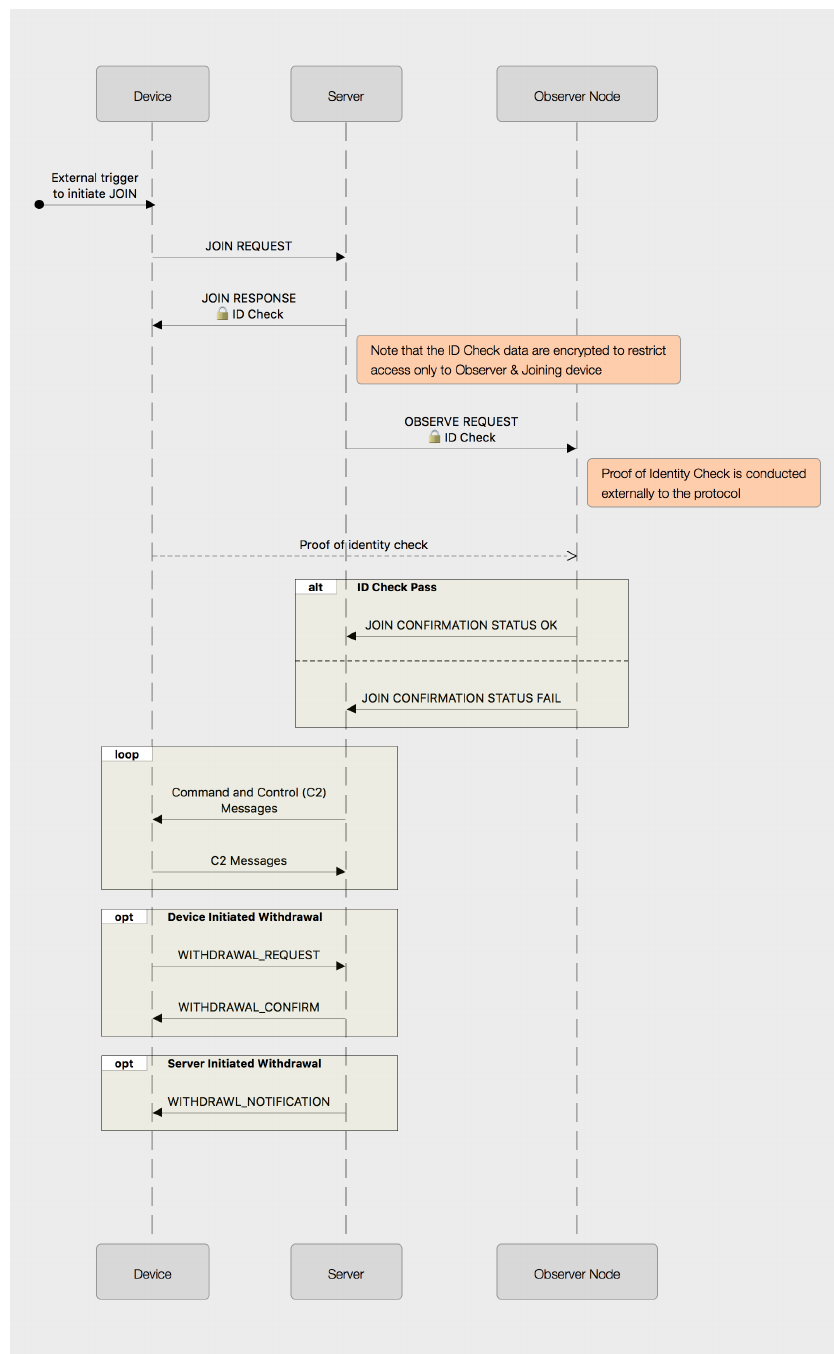
Figure 2. A sequence diagram showing the message flows for autonomous join and withdrawal operations. C2: command and